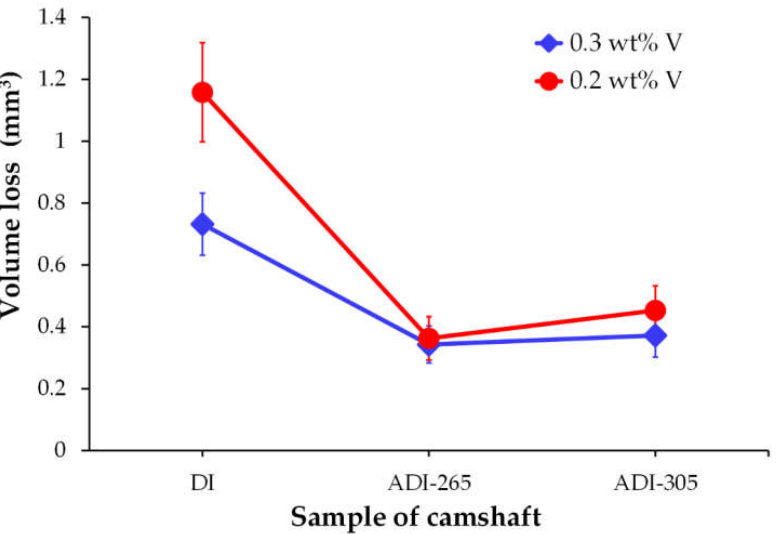
Figure 9. Effect of the austempering temperature and vanadium content on the wear resistance for the evaluated ADIs.